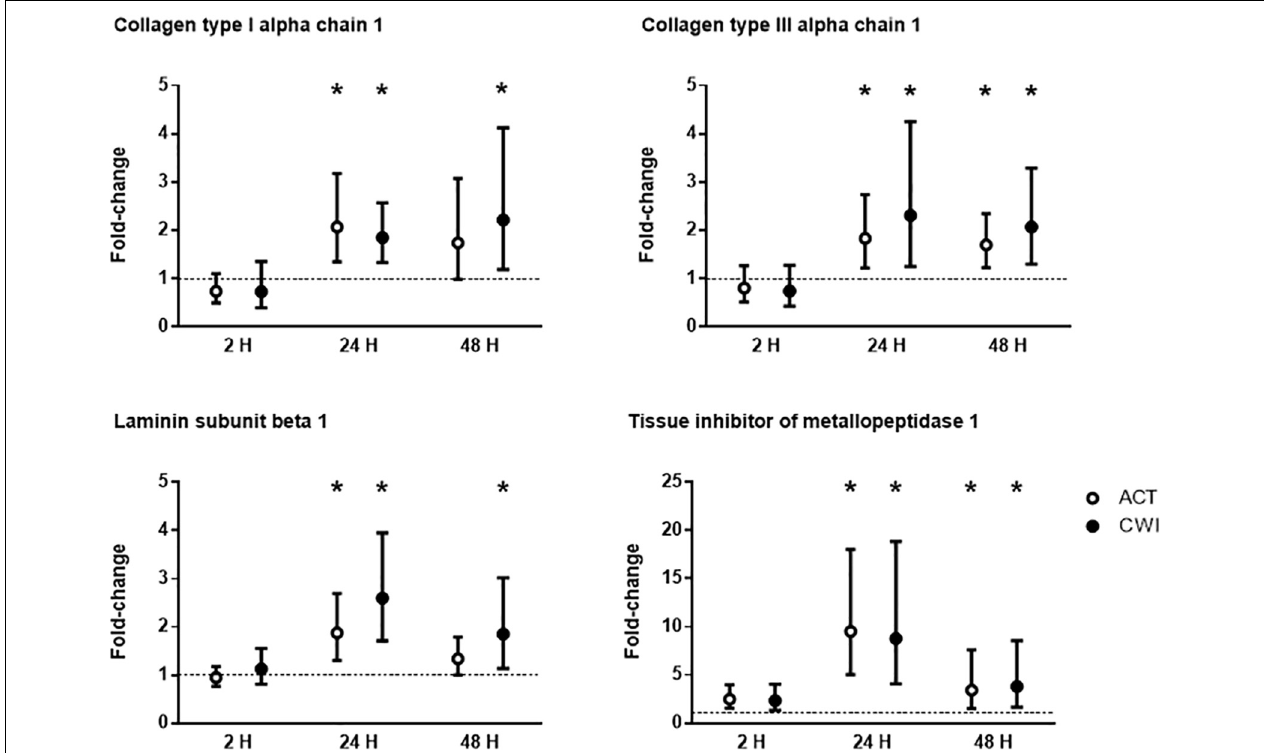
FIGURE 4 | Post-exercise changes in mRNA expression of collagen type I alpha chain 1, collagen type III alpha chain 1, laminin subunit beta 1 and tissue inhibitor of metallopeptidase 1. Data are presented as changes in the median ± interquartile range. * P < 0.05 versus pre-exercise. ACT, active recovery; CWI, cold water immersion. The dotted line represents a nominal pre-exercise value of 1.0 (for